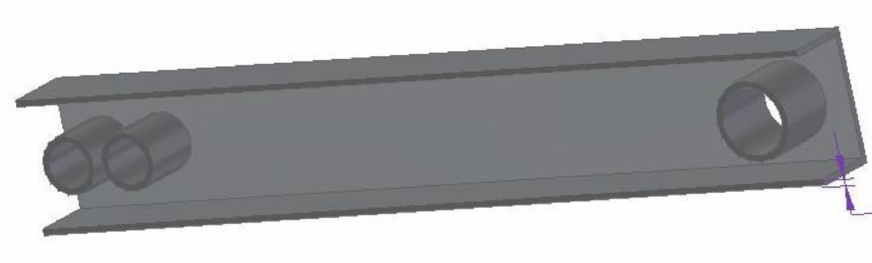
Figure 9. Longitudinal section of the metal shell.